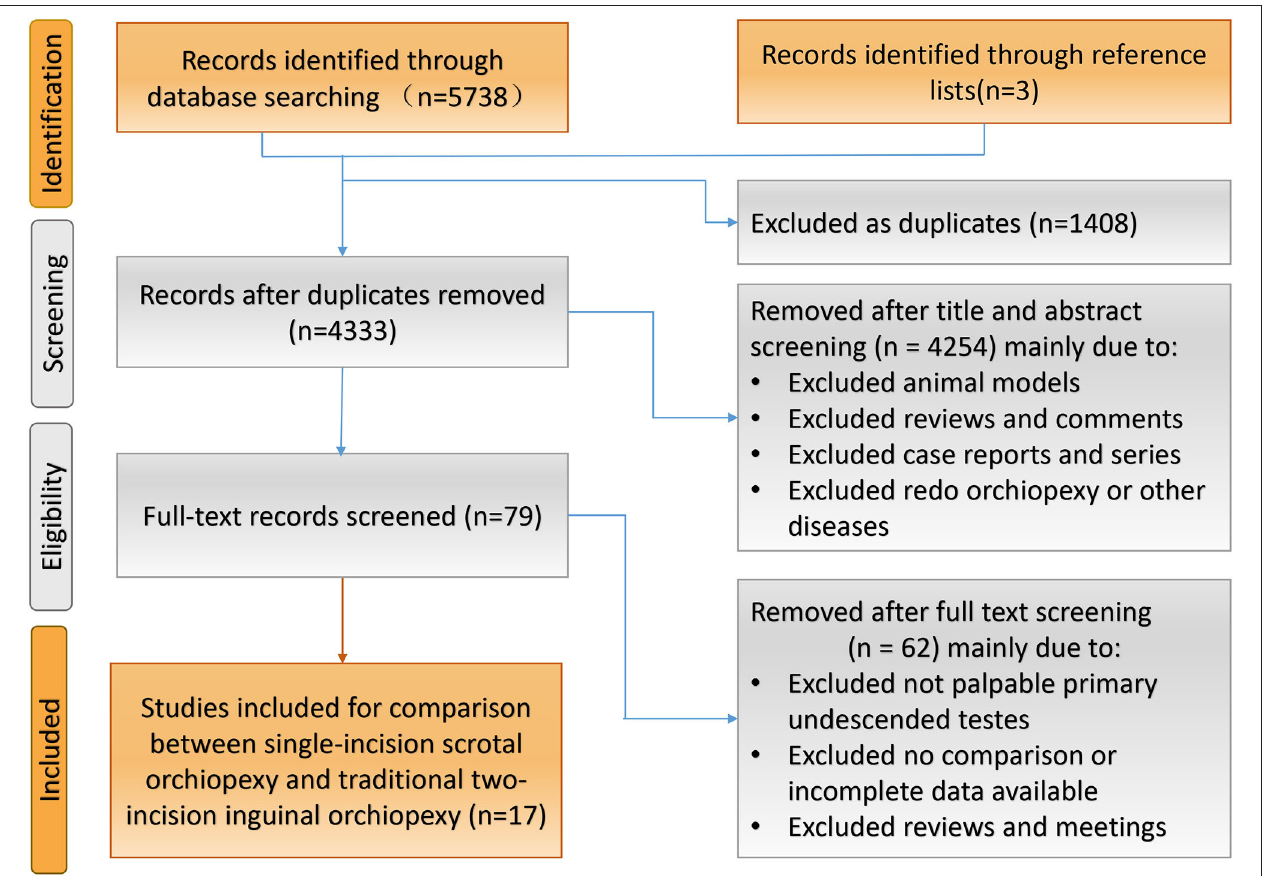
FIGURE 1 | Flow diagram of identification and eligibility of initial